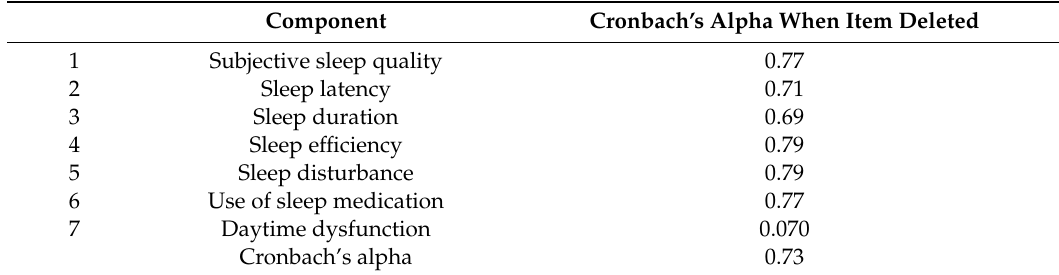
Table 2. Cronbach’s alphas for the PSQI